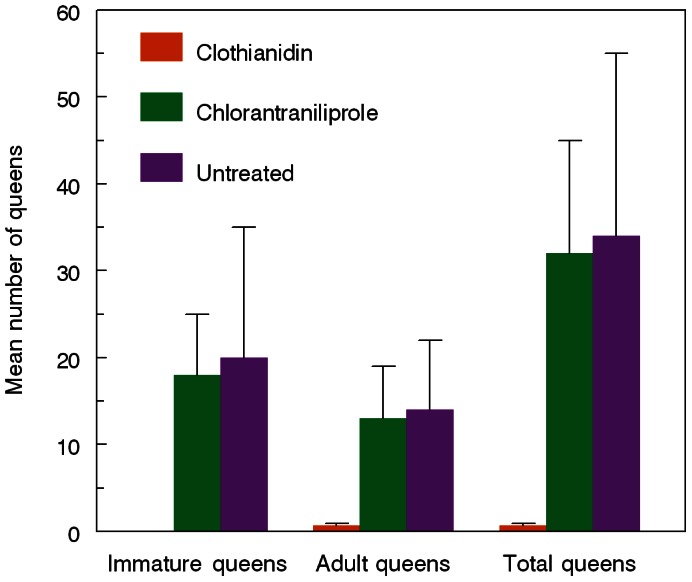
Queen production following exposure to treated turf.Mean (+ SE) numbers of queens produced by Bombus impatiens colonies that foraged for 6 days on insecticide-treated lawn turf with white clover and then were moved to an insecticide-free site to openly forage another 6 weeks (Friedman tests: Immature queens, P = 0.03; Adult queens, P = 0.08; Total queens, P = 0.05. Numbers of colonies (out of 10) that produced new queens were 0, 7, and 6 for clothianidin, chlorantraniliprole, and untreated hives, respectively. For the subset of colonies that produced new queens, those exposed to chlorantraniliprole-treated or untreated weedy turf produced similar numbers of immature, adult, and total queens (Kruskal-Wallis test, P = 0.69, 0.84, 0.95, respectively). Queens present in clothianidin exposed colonies likely represent the original mother queen.